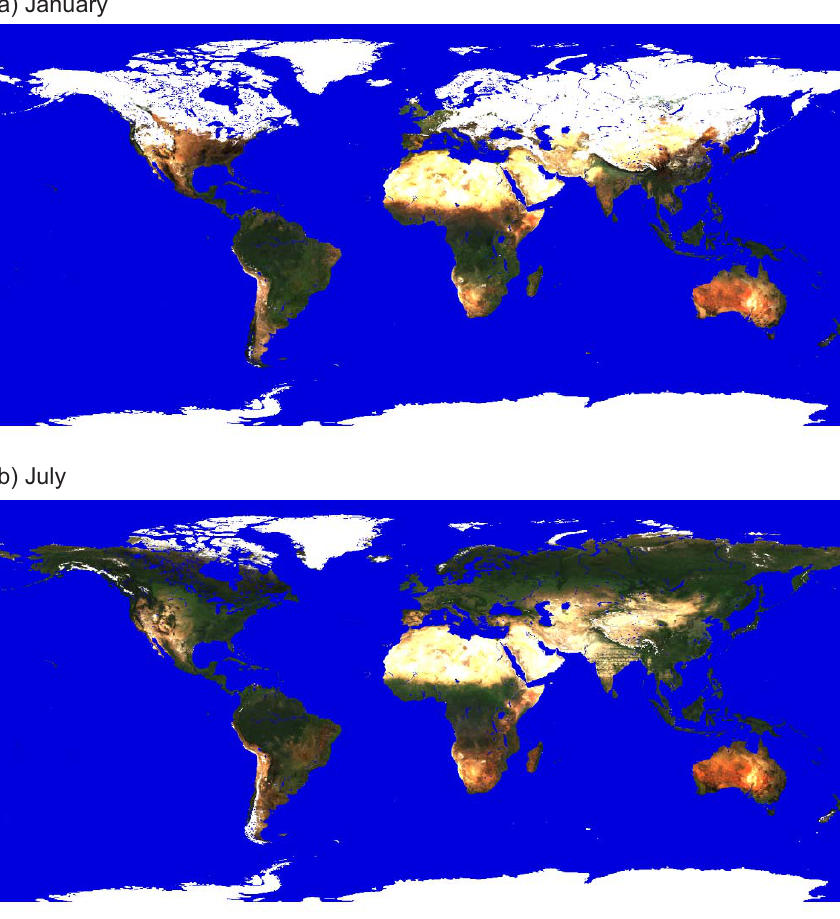
Fig. 2. RGB composites for the MERIS BSA dataset for January and July (R: 665nm, G: 650nm, B: 490nm). Oceans and larger inland water bodies are filled with an artificial blue